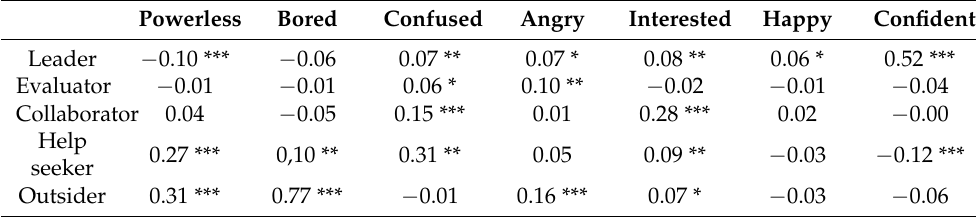
Table 3. Phi effect size values of the magnitude of associations between the variables from the positioning aspect and the variables from the emotions aspect. Powerless Bored Confused Angry